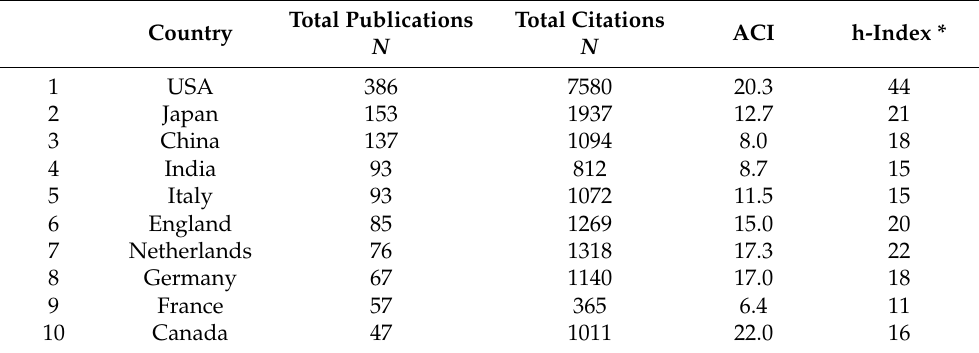
Table 1. Most productive countries publishing on ARM between 1970 and 2020.